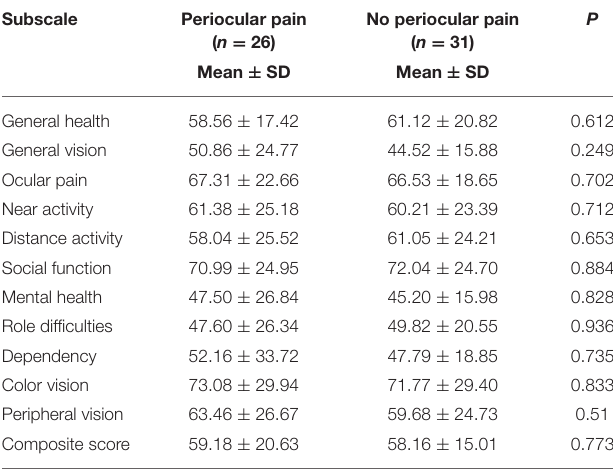
TABLE 4 | Analysis of each subscale and composite score between patients with and without periocular